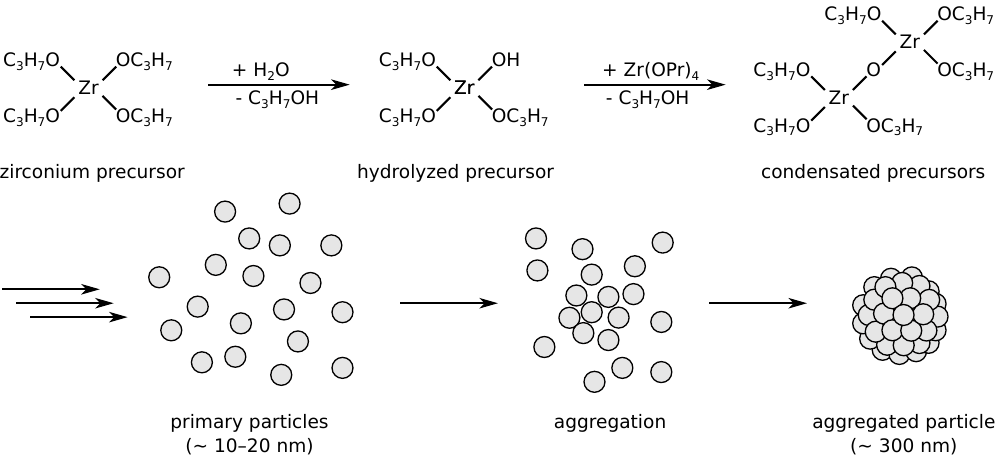
Figure 1. Schematic representation of aggregation-based synthesis of uniform, porous sol-gel zirconia submicro-particles from zirconium n -propoxide. Hydrolysis and condensation of the precursors is followed by primary particle formation and subsequent aggregation. Doped particles are obtained analogously by the use of mixed